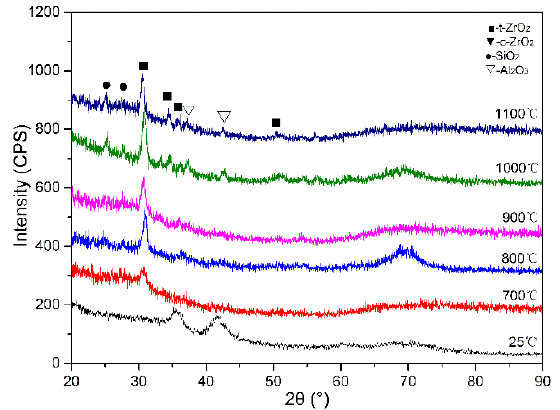
Figure 6. XRD patterns of the (AlCrTiZrMo)N/ZrO 2 nano-multilayered film with the ZrO 2 layer thickness of 0.6 nm after annealing at different temperatures for 30 min.